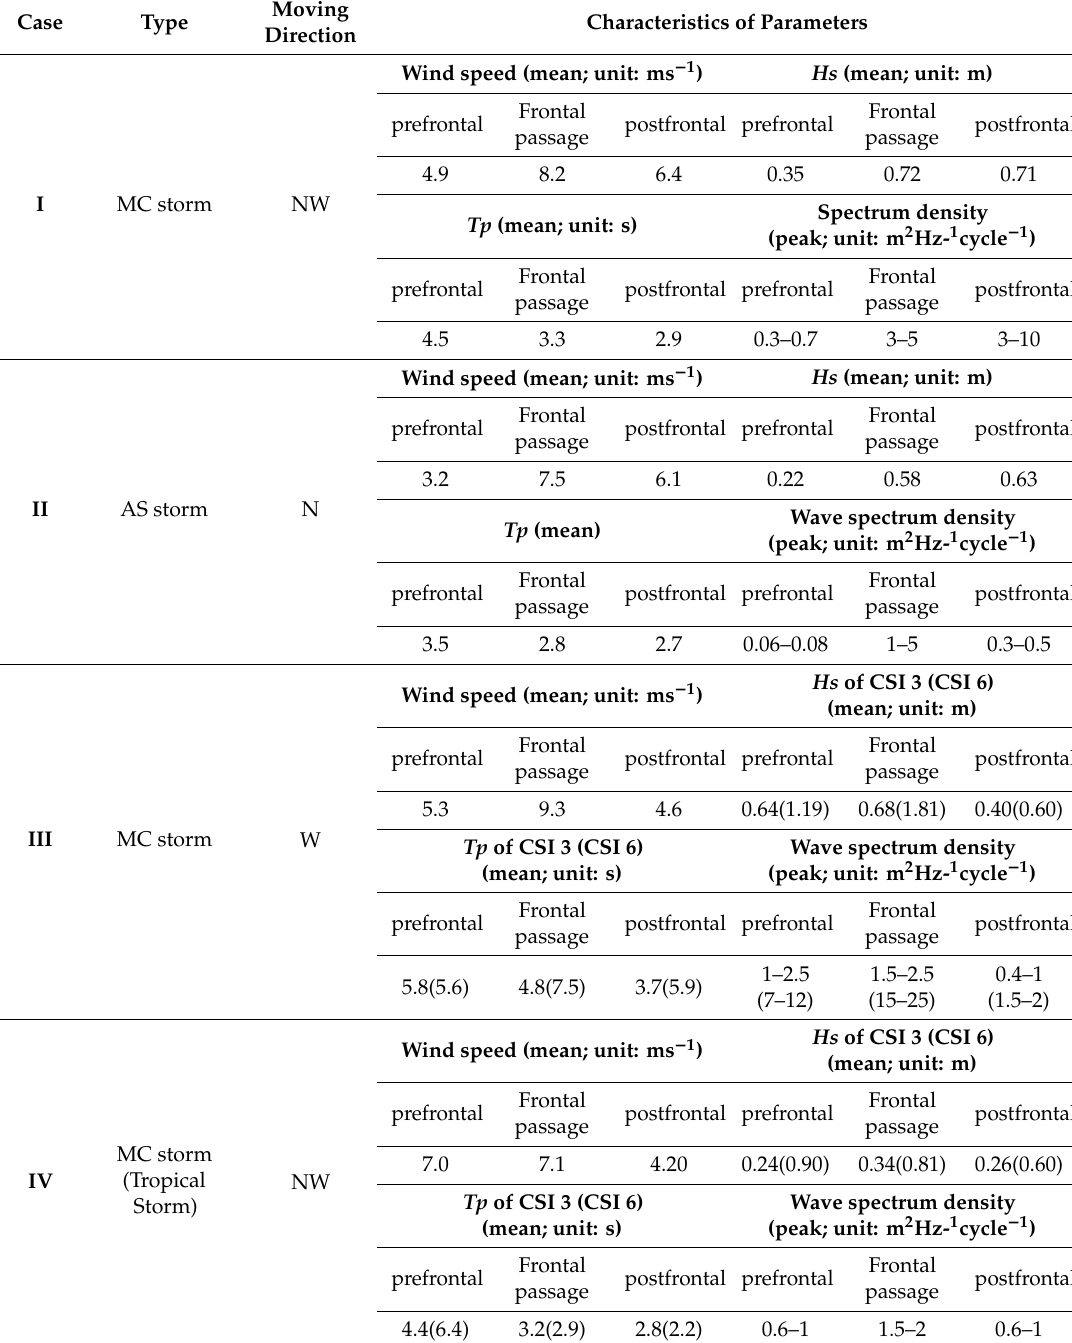
Table 2. Characteristics of wave parameters in three